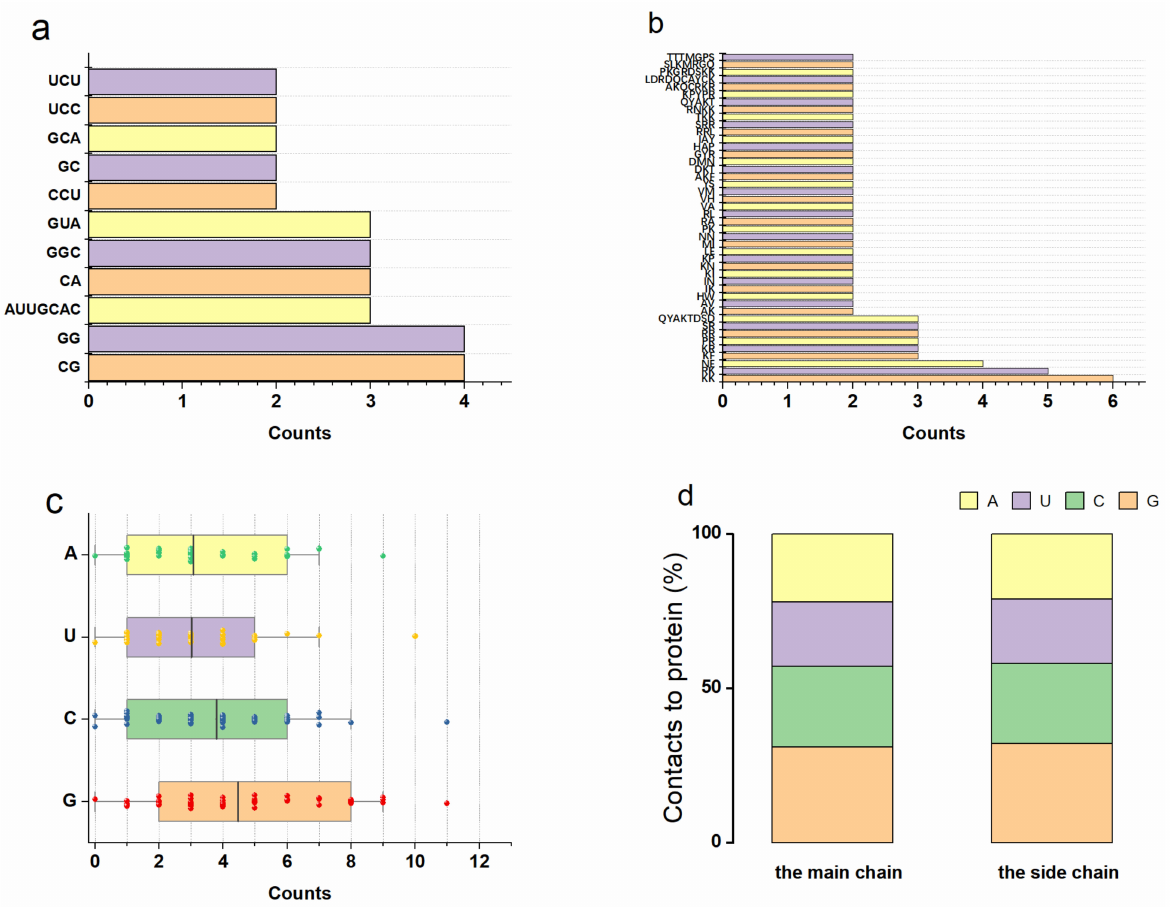
Figure 2. ( a , b ) The statistical results of the RNA/protein-binding fragments. ( c ) The RNA nucleotide distributions located at the RNA–protein interface. The distributions of G (31.3%) and C (26.4%) are significantly higher than A (21.5%) and U (20.8%). ( d ) The number of the RNA nucleotide backbone (phosphate and sugar) and side-chain (base) interactions with